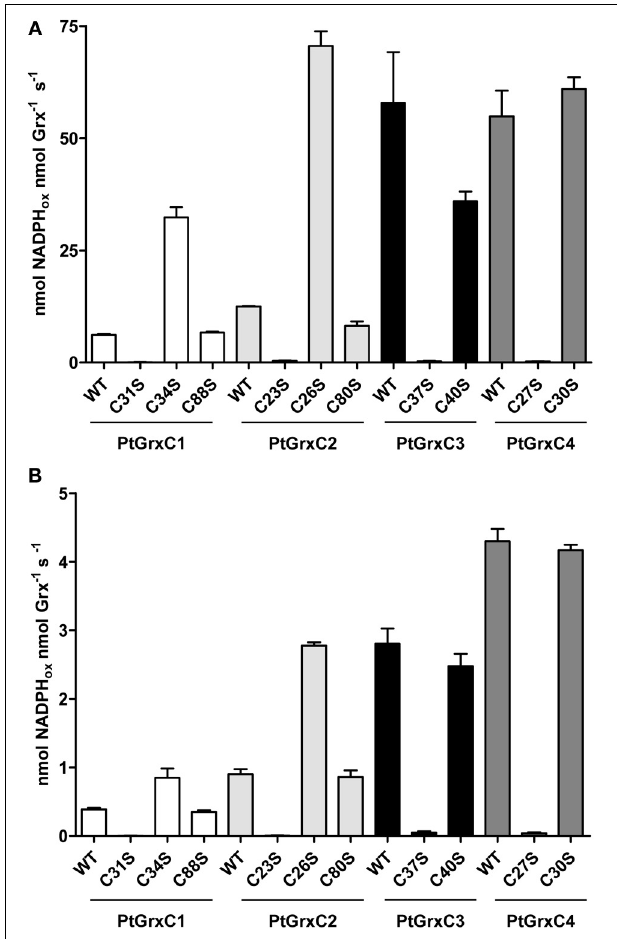
FIGURE 2 | Reductase activity of GrxC1, C2, C3, and C4 and of cysteine-to-serine variants. (A) HED reduction was measured in the presence of 2mM GSH and 0.7mM HED using either 100nM GrxC1, 20nM for GrxC1 C34S, 50nM GrxC2, 10nM for GrxC2 C26S, 10nM GrxC3, or 10nM GrxC4. (B) DHA reductase activity was measured in the presence of 2mM GSH and 1mM DHA using either 2 μ M GrxC1, 1 μ M for GrxC1 C34S, 1 μ M GrxC2, 250nM GrxC2 C26S, 200nM GrxC3, or 150nM GrxC4. The data are expressed as nmol NADPH oxidized per nmol enzymes per s and represent means ± SD of three separate